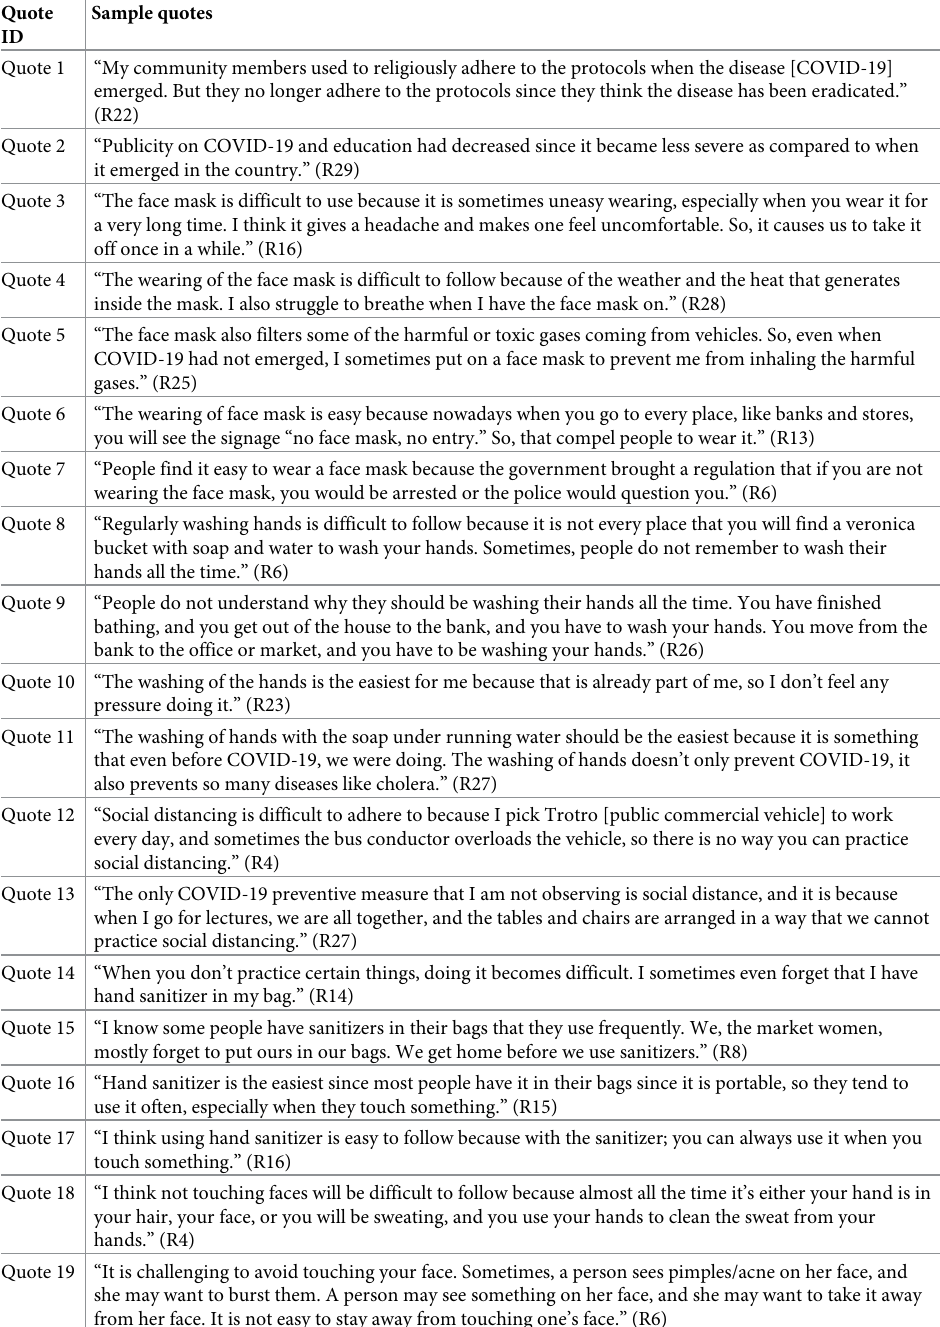
Table 2. Quotes on facilitators and barriers to adherence to COVID-19 preventive